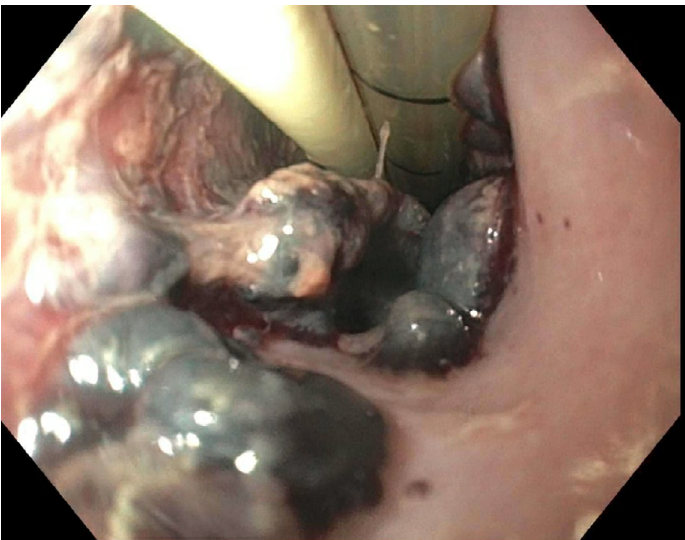
Figure 3. Necrotic mucosal protrusion in upper-third of the esophagus (endotracheal and orogastric tubes are also visualized)